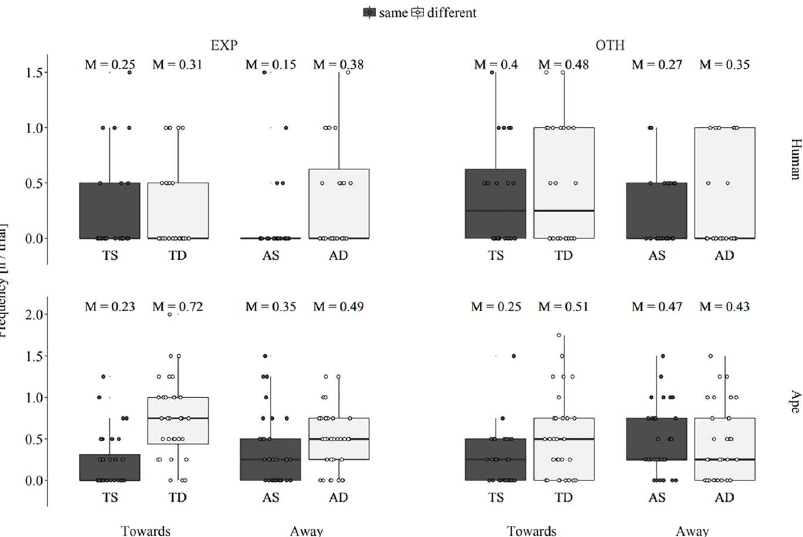
Fig 2. Box plot of the average number of times per trial that human infants (upper row) and apes (lower row) switched to the experimenter’s side (EXP: left column) and the other side (OTH: right column) across the factors orientation (Towards: two leftmost boxes in each plot, Away: two rightmost boxes in each plot) and location (red: experimenter and reward are on the sameside, blue: experimenter and reward are on different sides) resulting in the four experimental conditions towards-same (TS), towards-different (TD), away-same (AS) and away-different (AD); M: condition mean value, the middle line of each box represent population median values (different from the M above each box); lower and upper hinges display first and third quartiles, respectively; whiskers extend up to 1.5 x interquartile range, small circles represent individual data